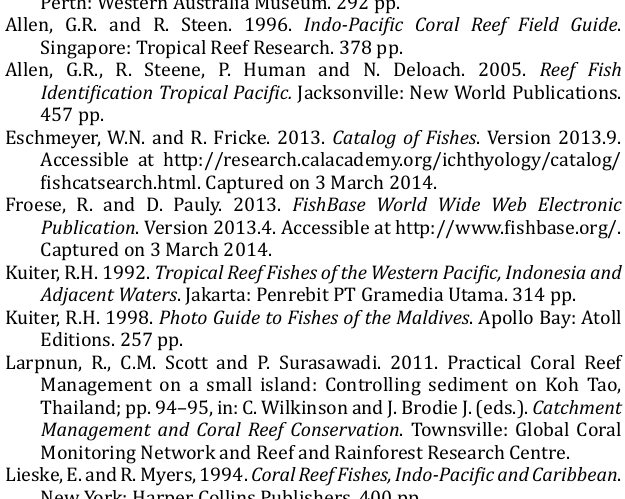
Synanceia verrucosa and cf. (Synanceidae)) are new records for the Gulf of Thailand. To date, 223 species of coral reef fishes belonging to 53 families are known from Koh Tao including the species found in the present study. For a discussion about zoogeographical analysis and faunal composition of the reef-fish fauna in Koh Tao and the Gulf of Thailand see Satapoomin (2000). Acknowledgements: Antennatus nummifer Dr. Patrick Louisy (association peau bleue) Histrio histrio assisted in identifying fish species. The photos of . (Figure 2B) and (Figure 2C) were taken by Sirachai Arunrugstichai Identification of seahorses was aided by Dr. Tse-Lynn Loh of the John G. Shedd Aquarium and Project Seahorse. Literature Cited Allen, G.R.